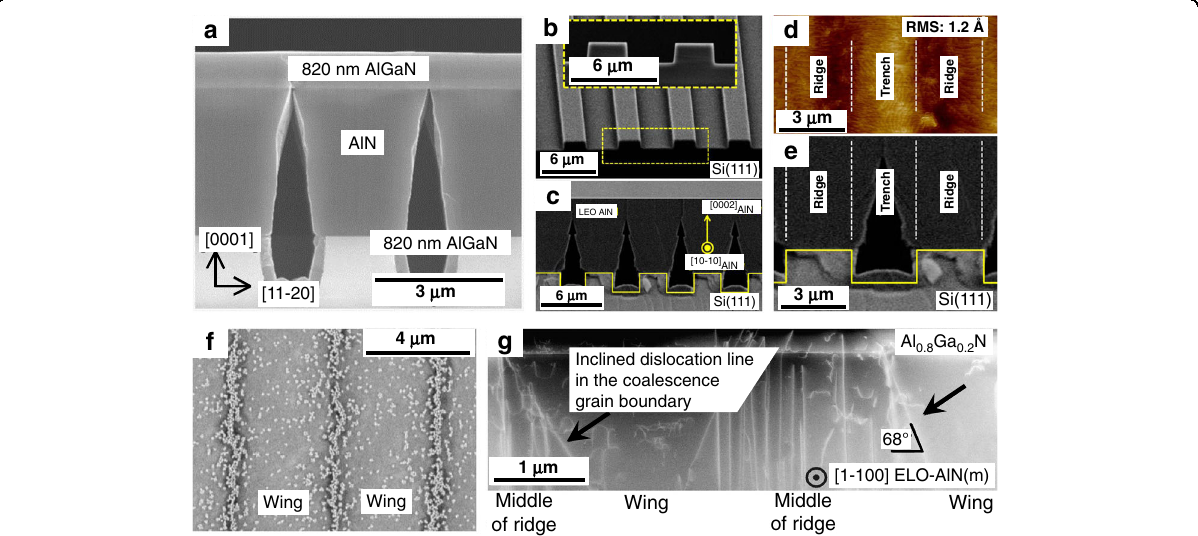
Fig. 5 Epitaxial lateral overgrowth for AlGaN fabrication. a Cross-sectional secondary electron image of AlGaN grown on an AlN ELO template. Reprinted with permission from Kueller et al. 117 . Copyright 2010 Elsevier B.V. b , c SEM images of the stripe-patterned AlN/Si(111) template. d AFM image of the ELO-AlN layer grown on the patterned Si template and corresponding cross-sectional SEM image of the patterned structure ( e ). Atomic steps are observed over the trenches. Reprinted with permission from Cicek et al. 118 . Copyright 2013 American Institute of Physics. f Plan-view SEM image of n-Al 0.8 Ga 0.2 N grown on ELO-AlN. g Cross-sectional annular dark- fi eld STEM image presents that the defect distribution in the ELO-AlN-AlGaN structure. Reprinted with permission from Mogilatenko et al. 116 . Copyright 2014 Elsevier